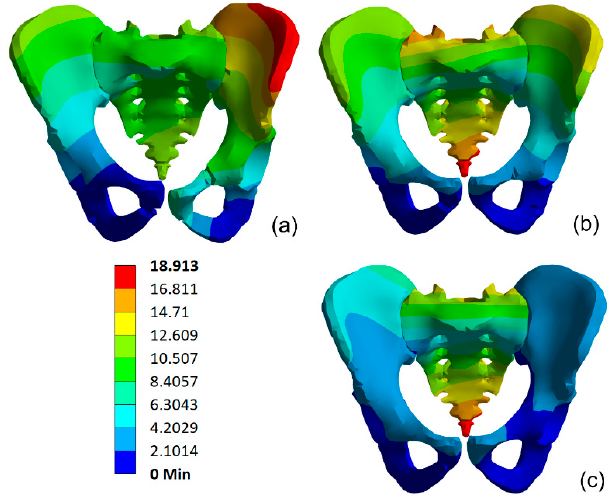
Figure 9. Displacements in the pelvis model for second support case for load impulse period time: ( a ) 4 ms, ( b ) 2 ms, ( c ) 1 ms.